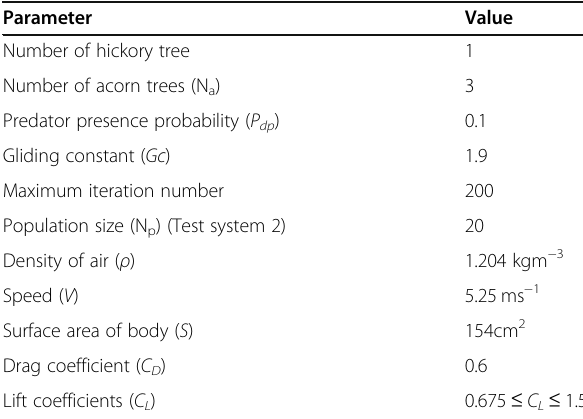
Table 1 Optimum FSSA parameters